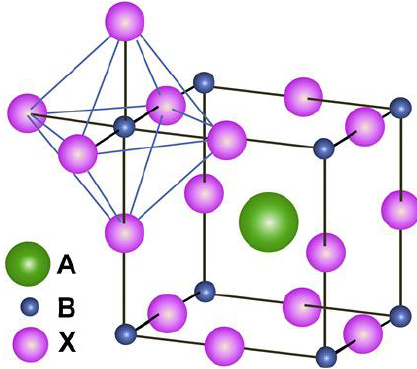
Figure 3. The structure of organic-lead trihalide perovskite ABX 3 . Reprinted with permission from the reference